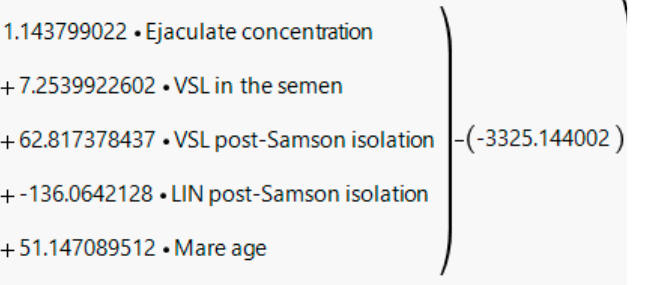
Figure A10. Equation optimized for stallion 4 from the post-chilled data set: predictive accuracy of 100%.